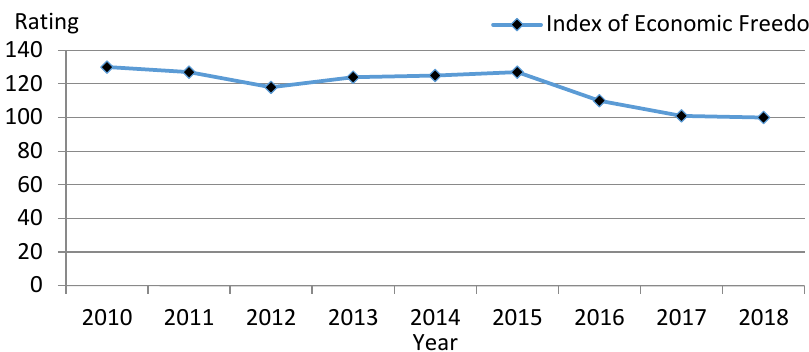
Fig. 1: The Index of Economic Freedom (UIR, 2019)